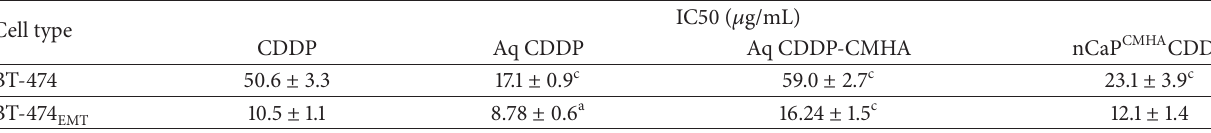
Table 2: Tabulated IC50 values of CDDP, Aq CDDP, Aq CDDP-CMHA, and nCaP CMHA CDDP examined with BT-474 and BT-474 cells, EMT from curves shown in Figures 7(a) and 7(b), respectively. For BT-474 cells Aq CDDP and nCaP CMHA CDDP were both significantly more cells nCaP CMHA CDDP was as effective than CDDP alone and Aq CDDP-CMHA was significantly less effective than CDDP. For BT-474 EMT cytotoxic as CDDP alone and Aq CDDP was significantly more effective while Aq CDDP-CMHA was significantly less effective. IC50 ( 𝜇 g/mL) Cell type CDDP Aq CDDP Aq CDDP-CMHA nCaP CMHA CDDP BT-474 50.6 ± 3.3 17.1 ± 0.9 c 59.0 ± 2.7 c 23.1 ± 3.9 c BT-474 10.5 ± 1.1 8.78 ± 0.6 a 16.24 ± 1.5 c 12.1 ± 1.4 EMT a 𝑃 ≤ 0 . 05 . c 𝑃 ≤ 0 . 001